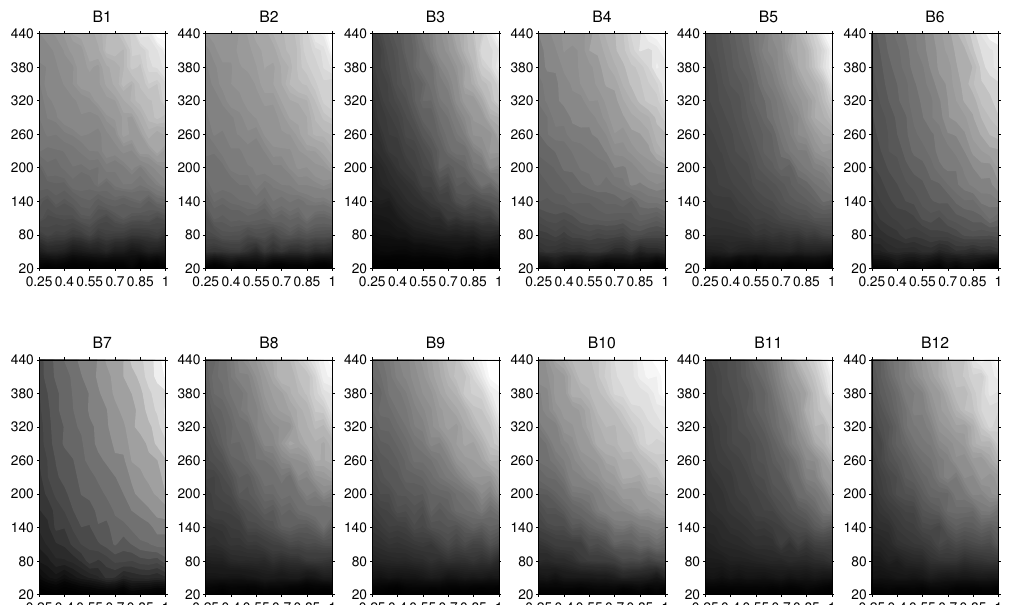
Fig. 2. ESN training performance (averaged over 10 runs) over a range of values for the reservoir size (y-axis) and spectral radius (x-axis). Lighter shades represent a low MSE, darker shades a high MSE.